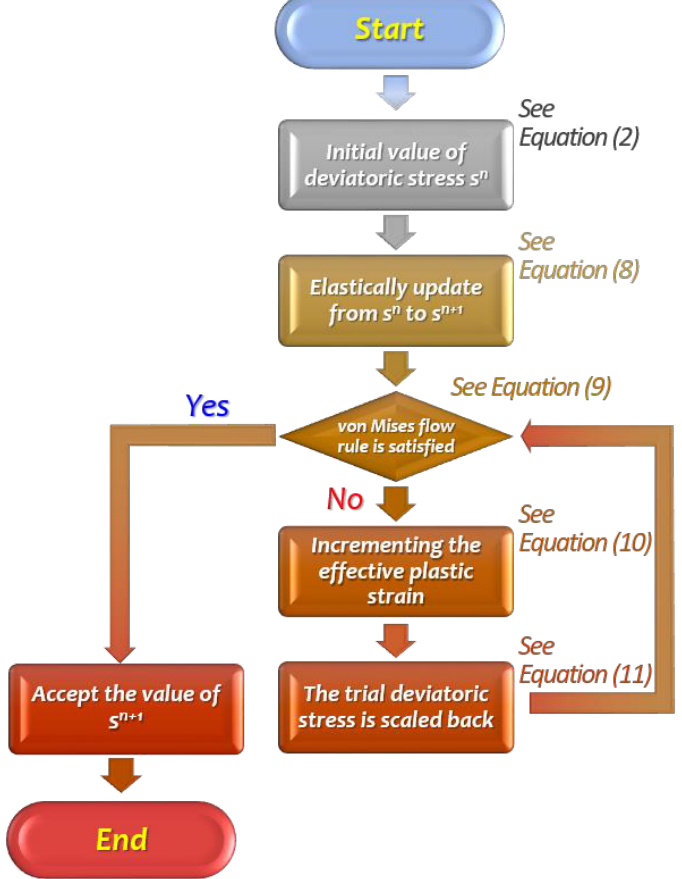
Figure 3. Algorithm of piecewise linear plasticity material model.